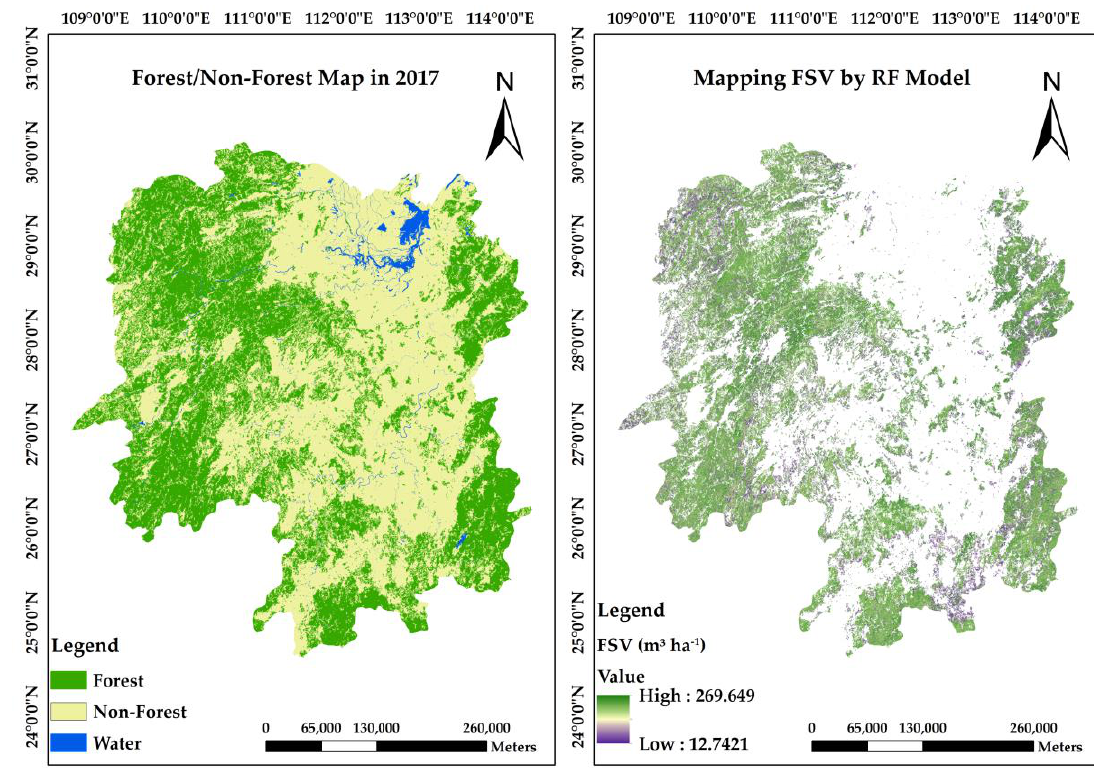
Figure 9. The PALSAR-2/PALSAR Forest/Non-Forest Map in 2017 (left), and the predicted FSV map in 2017 in Hunan Province (right).